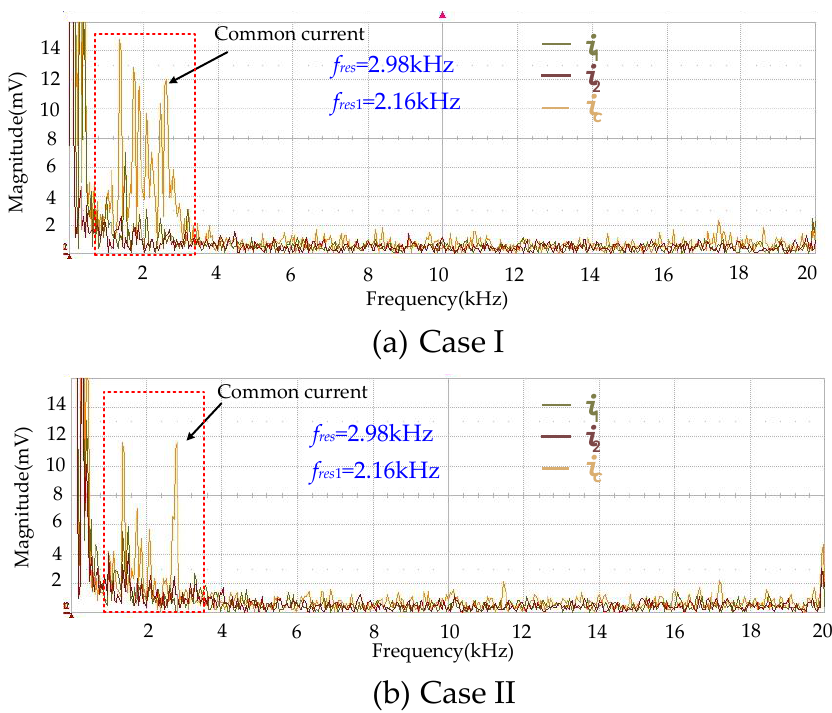
Figure 13. Harmonic analysis under the conventional scheme presented in [7].